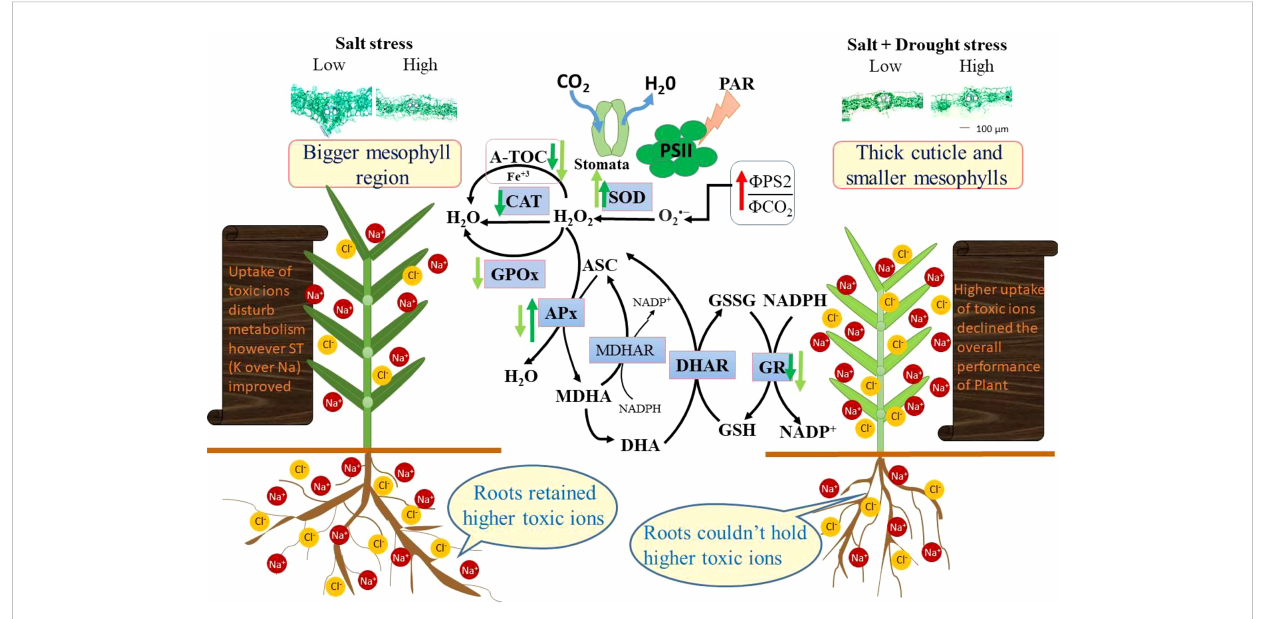
FIGURE 6 Schematic presentation of the individual (salinity) and combined (salinity + drought) stressors-induced alterations in ion regulation, antioxidant machinery and anatomical features of a halophytic grass P. antidotale . Arrows (up- or down-head) display an increase or decrease in a parameter ’ s response compared to control plants. The length of the arrow increases with increasing response difference. For each response, the arrow on the left stands for individual stress and on the right for combined stresses. SOD, superoxide dismutase; CAT, catalase; GPOx, glutathione peroxidase; APx, ascorbate peroxidase; DHA, ascorbate oxidized state; ASC, ascorbate reduced state; GSH, glutathione reduced state, GSSG, glutathione oxidized state; GR, glutathione reductase; F PSII/ F CO 2 , the ratio between quantum ef fi ciencies of electron transport and CO 2